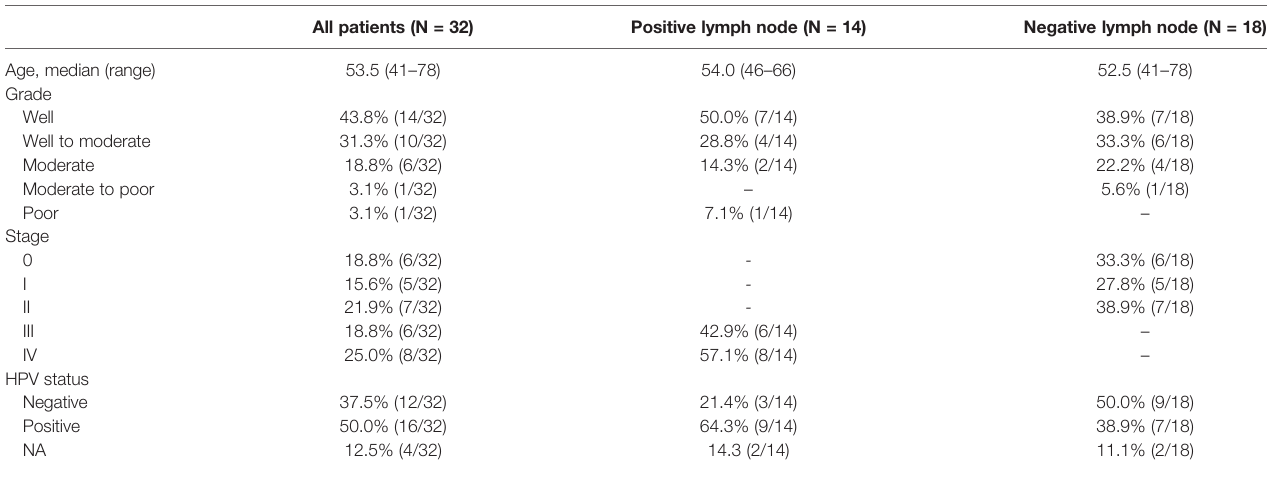
TABLE 1 | Patient